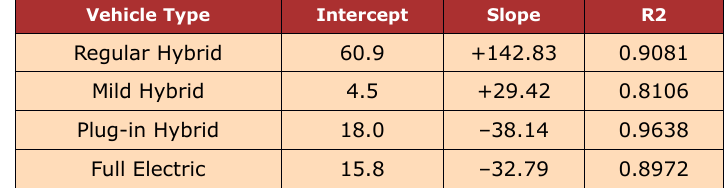
Table 3. Comparison of Histogram with Gamma